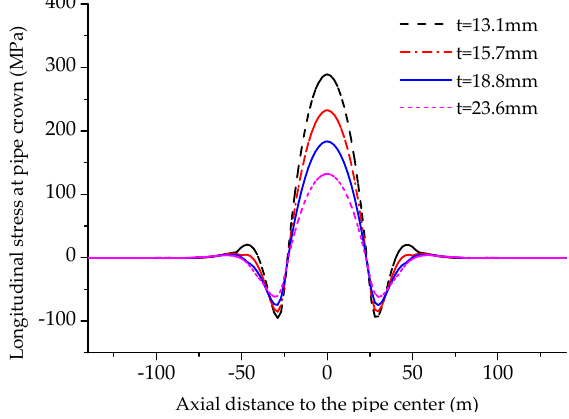
Figure 15. Longitudinal stresses at pipe crown for pipes with various wall thicknesses. Energies 2018 , 11 , x FOR PEER REVIEW